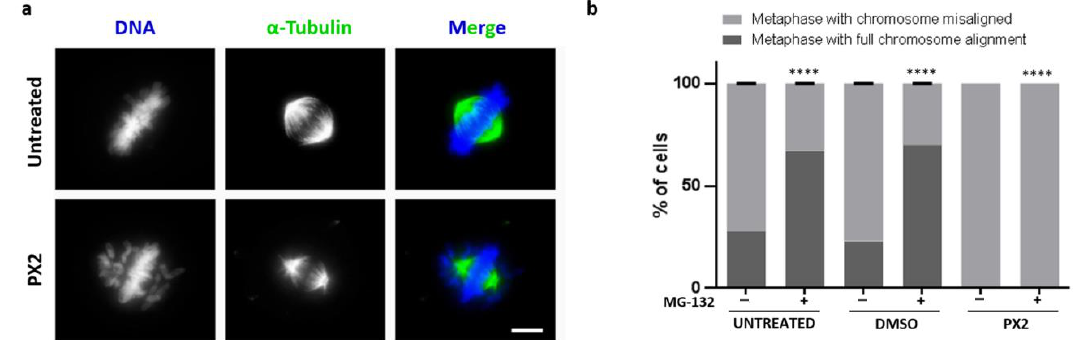
Figure 3. Pyranoxanthone 2 (PX2) treatment results in chromosome misalignment phenotype. ( a ) Immunofluorescence images of an untreated cell in metaphase with all chromosomes aligned at equatorial zone (Top), and a PX2-treated cell, arrested in prometaphase-like state, showing many misaligned chromosomes (Bottom). Microtubules (green) were stained with anti- α -tubulin antibody and DNA (blue) with 4’,6’-diamino-2-fenil-indol (DAPI). Bar, 5 µ m. ( b ) Graphical representation of data shown in ( a ), in absence ( − ) or presence ( + ) of proteasome inhibitor MG-132 with statistical relevance of **** p < 0.0001 by two-way ANOVA with Tukey’s multiple comparisons